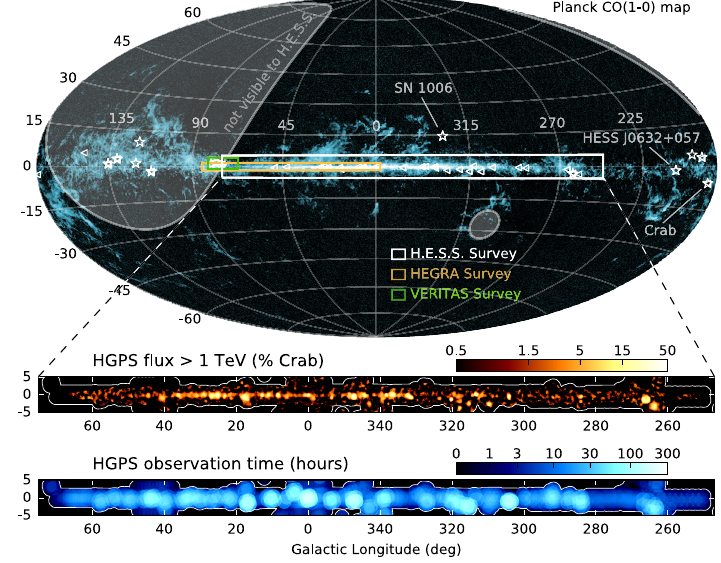
Figure 1. H.E.S.S. Galactic Plane Survey region, flux map and exposure map (from top to bottom). The all-sky image on the top panel shows a Planck CO Map with Fermi -LAT identified Galactic 1FHL sources (triangles) and the 15 known Galactic TeV sources (white stars) outside the HGPS region. The HEGRA Galactic Plane Survey [12] and the VERITAS Cygnus survey [13, 14] regions are illustrated in blue and green, respectively. From